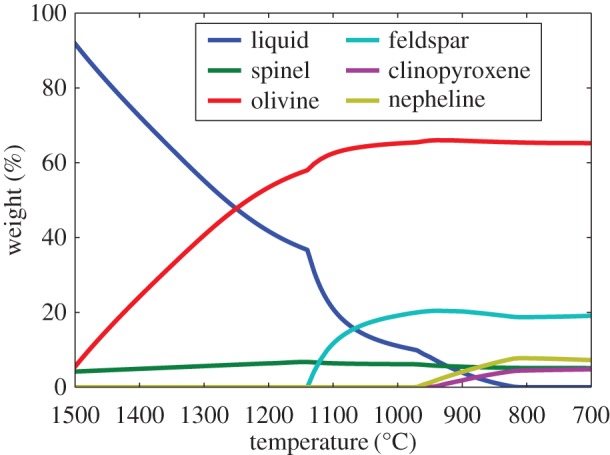
Iris crystallization sequence. MELTS (model) predicted phase abundances as a function of temperature for the fugacity log(log(fO2)) = IW – 0.25, Na2O=3.5 wt%. At high temperature, olivine and spinel were co-forming (reproduced with permission from [14], fig. 19. Copyright © 2015 John Wiley & Sons, Inc.). (Online version in colour.)